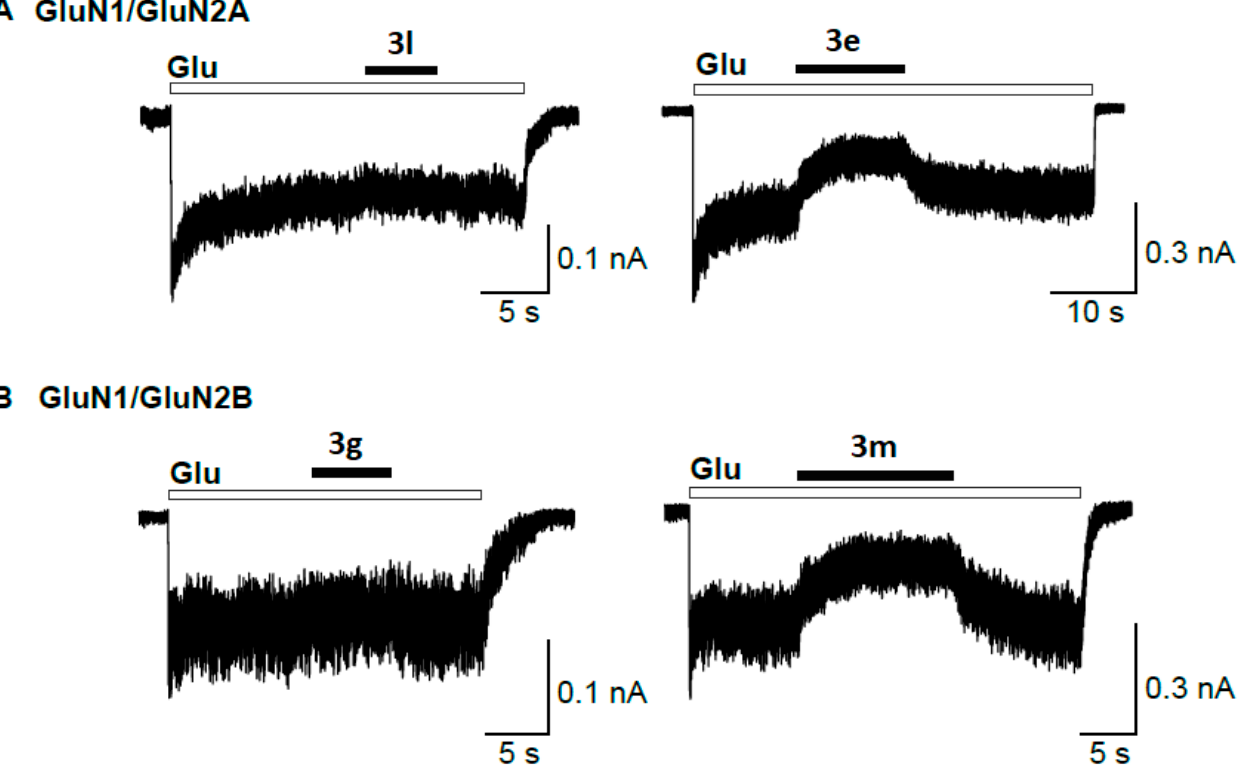
Figure 5. The examples of the most ( 3e and 3m ) and least ( 3l and 3g ) potent compounds from all tested fluoren-9-amines at the NMDARs. Representative whole-cell currents induced by 1 mM of glutamate (Glu) and 50 µM of glycine at the negative ( − 60 mV) membrane potential with ( A ) the least potent compounds: 3l measured at GluN1/GluN2A and 3g at GluN1/GluN2B NMDARs and ( B ) the most potent compounds: 3e measured at GluN1/GluN2A and 3m at GluN1/GluN2B NMDA receptor (see Table 3).